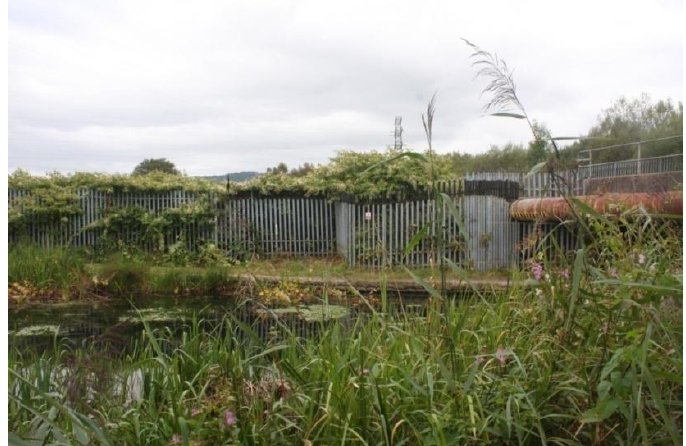
Figure 11. Point 18 (51°64′67.2″N, 03°82′50.2″W), showing F. japonica var. japonica stand(s) detected by algorithm, but not by specialist field survey. Image capture: 14/09/2009.